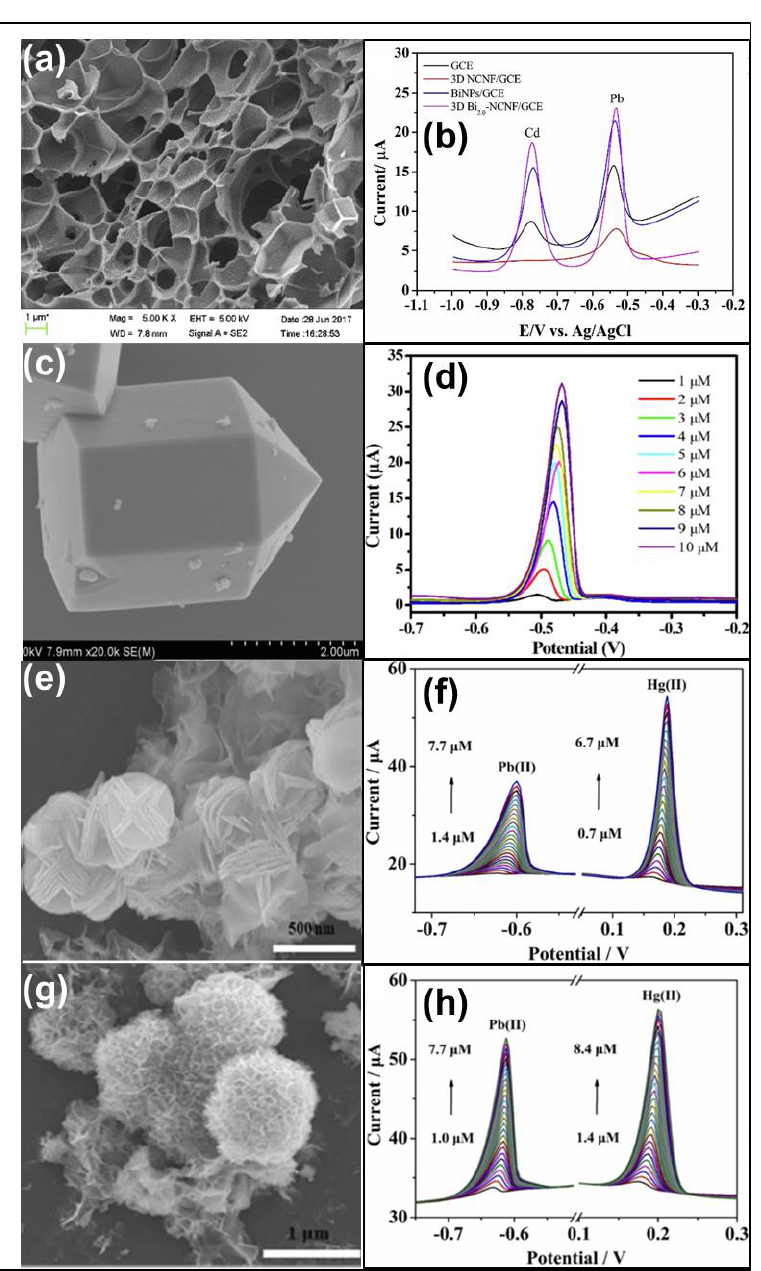
Figure 4. ( a ) SEM image of 3D honeycomb-like structure and ( b ) SWASV curve of Bi 2.0 -NCNF for simultaneous detection of Cd and Pb ions [46], ( c ) SEM image of hexagonal prism with hexagonal pyramid tip, ( d ) DPV curve of V 2 O 5 @MOF for detection of Pb ions with Ag/AgCl (3 M KCl) as the reference electrode [48], ( e ) SEM image of blooming flower-like structure, ( f ) SWASV of NMO-GR for detection of Pb and Hg ions with Ag/AgCl as the reference electrode, ( g ) SEM image of carambola like structure, and ( h ) SWASV of ZMO-GR for detection of Pb and Hg ions with Ag/AgCl as the reference electrode